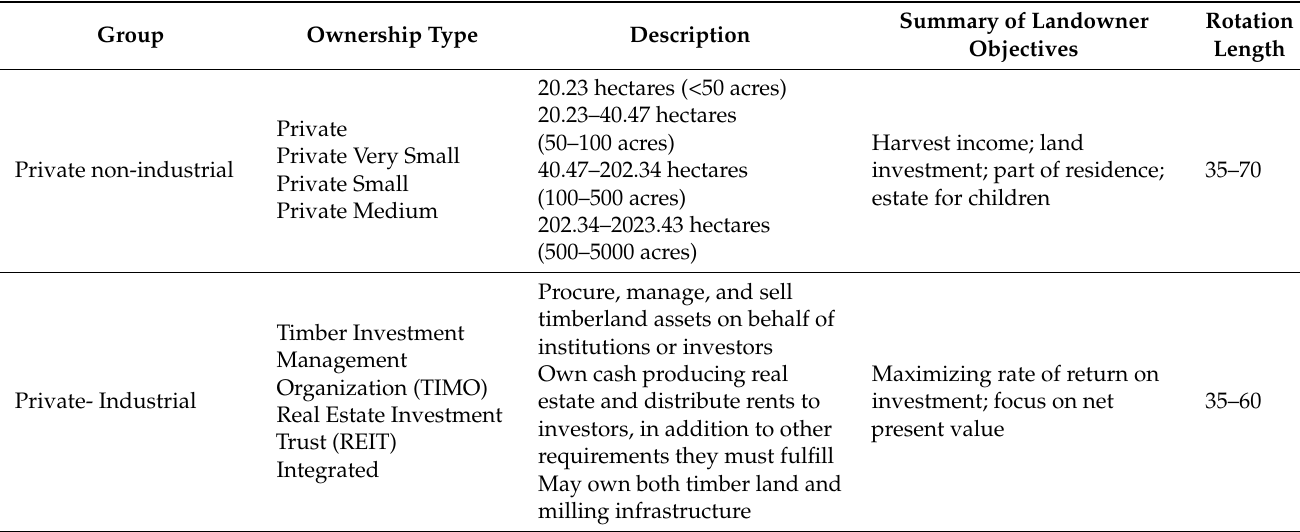
Table 1. Ownership types used in analysis. Landowner objectives are from [69] and Derek Churchill (Washington Depart- ment of Natural Resources; personal communication, 3 December 2019). Ownership types are grouped by the ownership groups identified through hierarchical classification (Sections 2.5 and 3.2). Rotation length is the average number of years between harvests